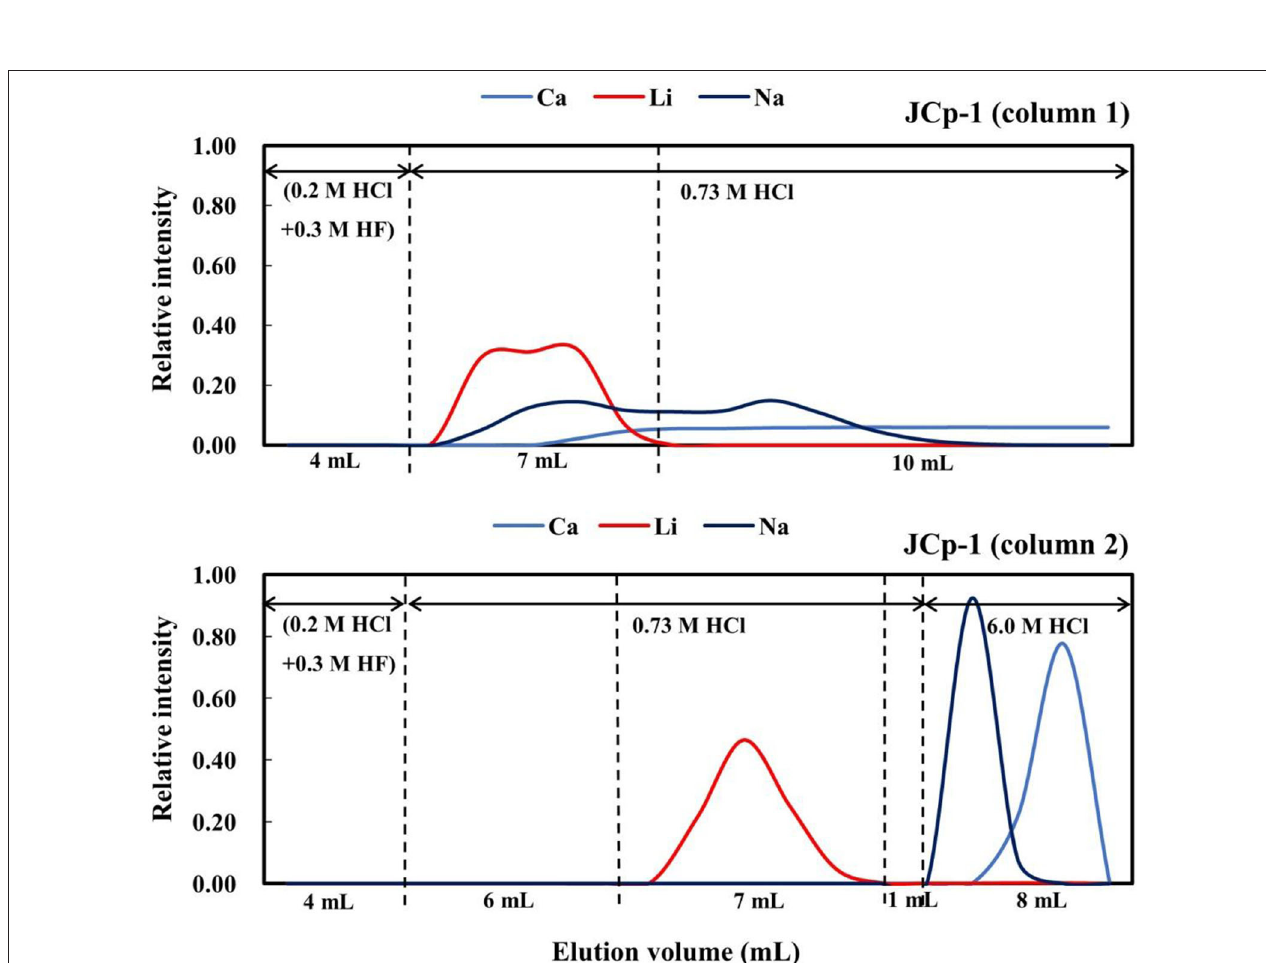
FIGURE 3 | Elution curves for the carbonate reference material JCp-1 on AGMP-50 resin.